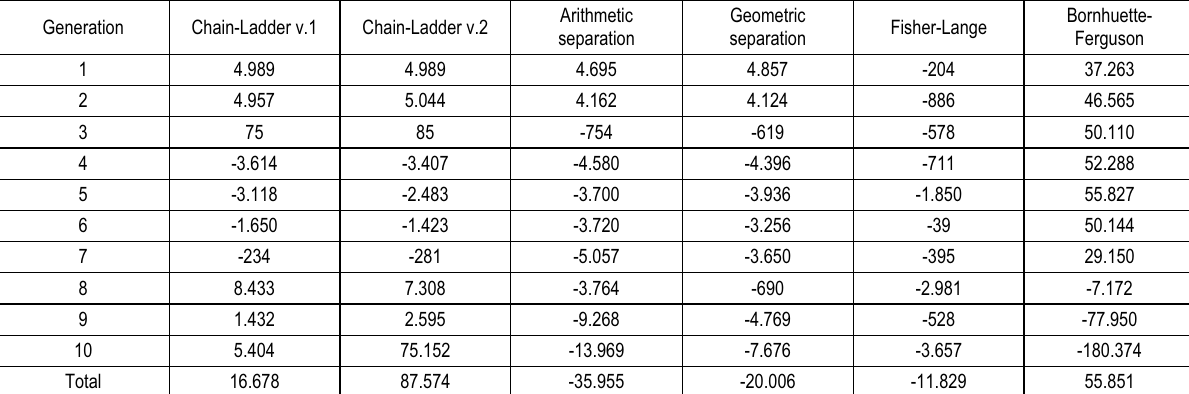
Table 10. Bias method of single settlements